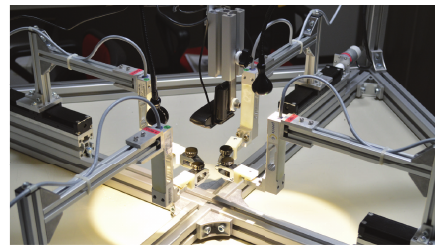
Figure 1: Biaxial test